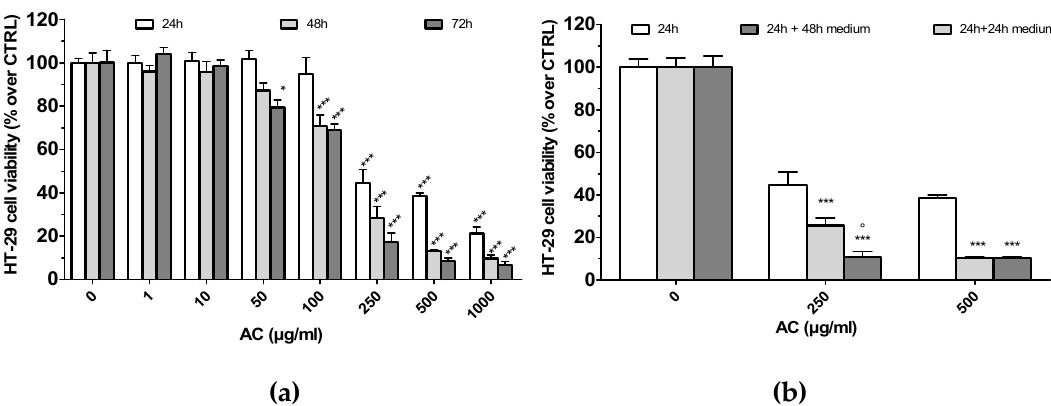
Figure 2. ( a ). Human colorectal adenocarcinoma HT-29 cells’ viability after treatment with Acacia catechu Willd. extract (AC) for 24, 48 and 72 h. Panel B. Reversible or irreversible cytotoxic effect caused by AC. HT-29 cells were treated with AC (250 and 500 µg/mL, 24 h). Afterward, AC was washed off and cells were incubated with fresh serum-containing medium for an additional 24 or 48 h. After each time point, MTT test was performed as detailed in Materials and Methods. In both